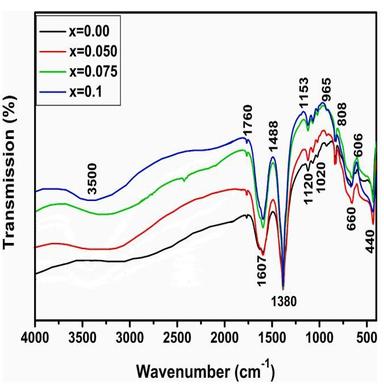
FTIR spectra of CoFe2-xSmxO4 (a) x = 0.0, (b) x = 0.050 (c) x = 0.075 (d) x = 0.1 ferrites.